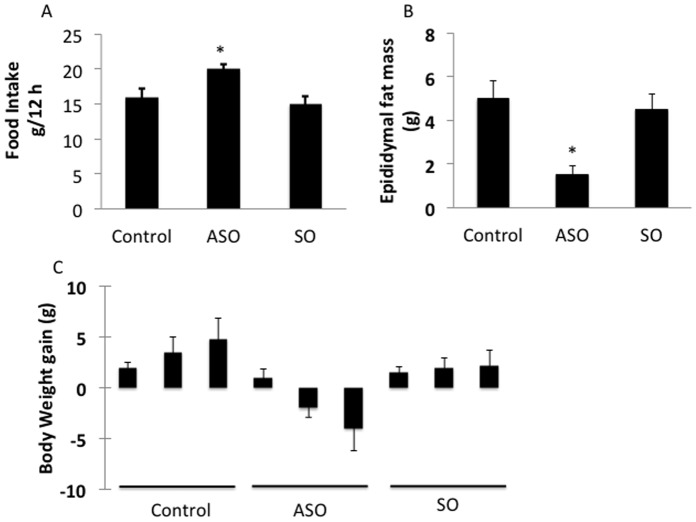
Anthropometric evaluation and feeding behavior in ASO-ACC and ACC-SO mice.Food intake (A), epididymal fat mass (B) and body weight (C) in control, ACC-ASO (ASO) and ACC-SO (SO) rats. Data are means ± SEM of 8–10 rats. (A)*p≤0.05 vs. control and SO rats.